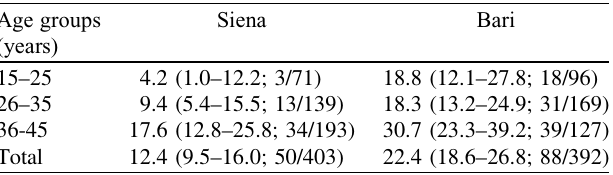
Table 1. Prevalence of anti- T. gondii IgG in samples collected from women of childbearing age in Siena (2013, 2014, and 2016) and Bari (2015, 2016), divided by age groups (%, 95% CI; positive/total).